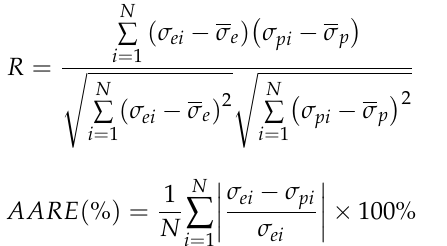
Figure 6. Comparison between the predictive value of the constitutive model fitted by a power- exponential function and the experimental stress-strain curves at temperature of ( a ) 320 °C, ( b ) 380 °C, ( c ) 440 °C and ( d ) 500 °C, respectively. In order to improve the prediction accuracy, the constitutive model fitted by a higher- order polynomial was developed. The stress was expressed as a polynomial function of